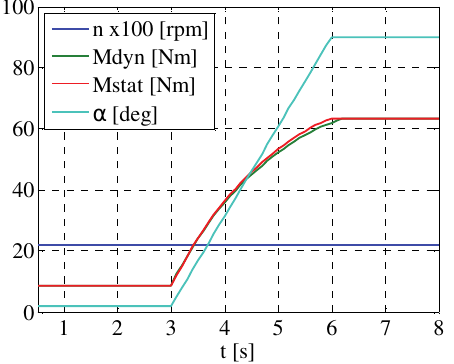
Fig. 11. Increase in engine torque with constant speed while full throttle opening Fig. 11 clearly shows that there is a very small difference between values calculated by characteristics in static and dynamic states. Fig. 12 shows that the difference δ is the largest in the range of small engine speed and equals about 4%. Then decreases with increasing engine speed. Fig. 14. Engine parameters during full throttle opening lasting 1